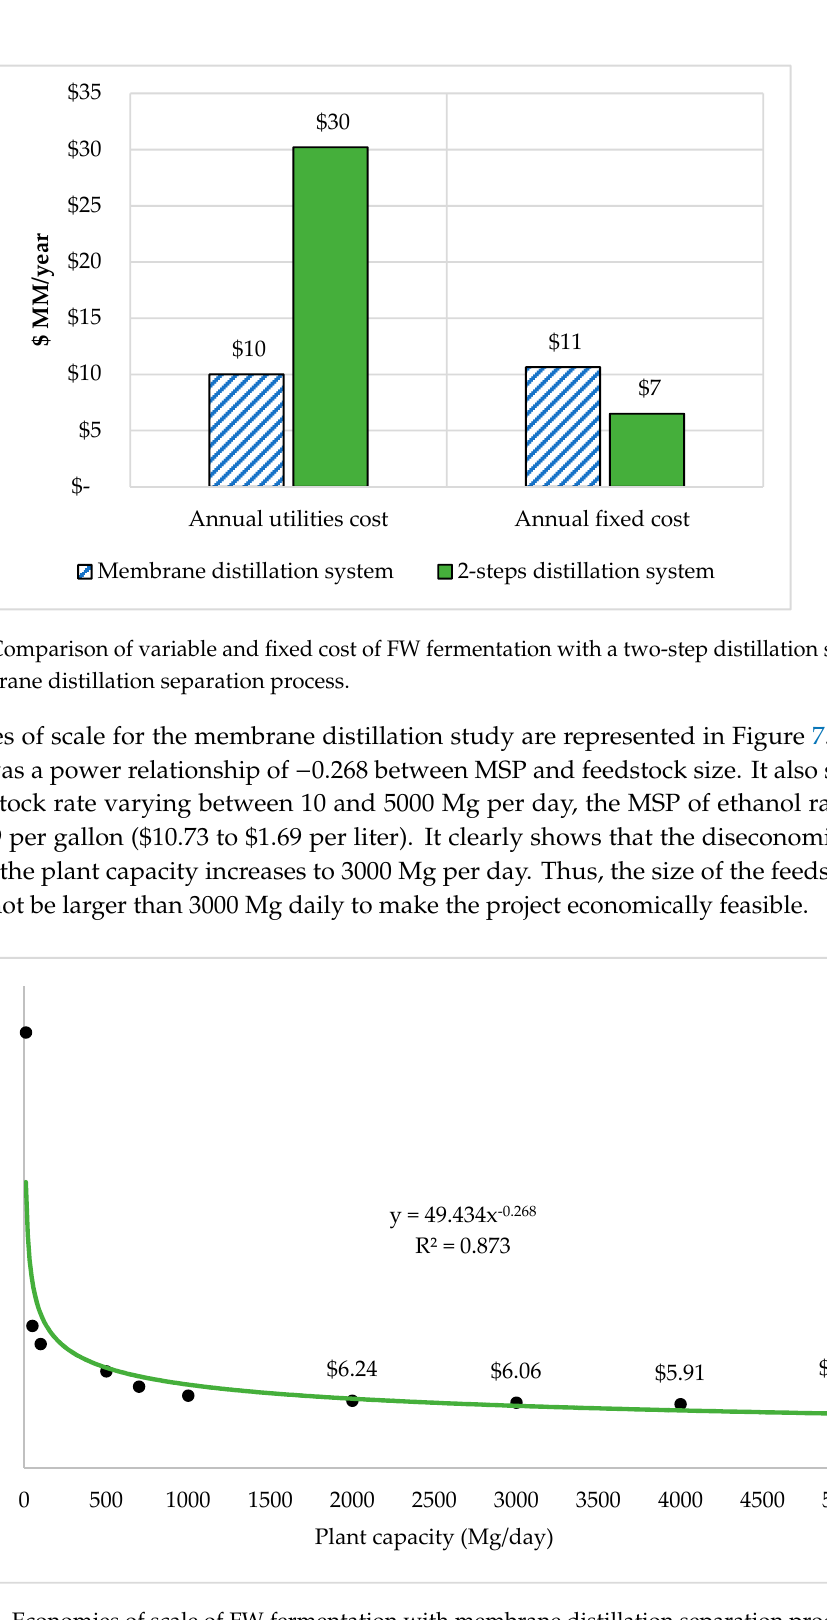
Figure 7. Economies of scale of FW fermentation with membrane distillation separation process.